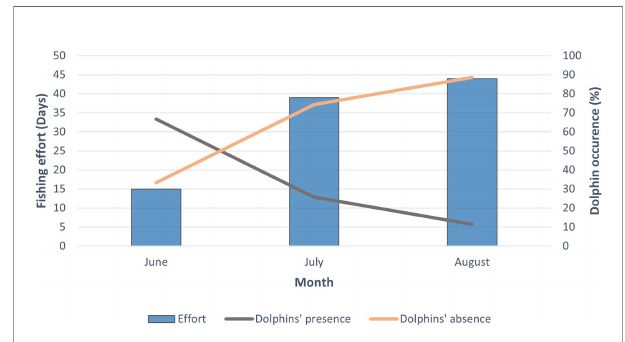
FIGURE 3 | Relationship between fi shing effort (days) and days with and without dolphin depredation (%) for